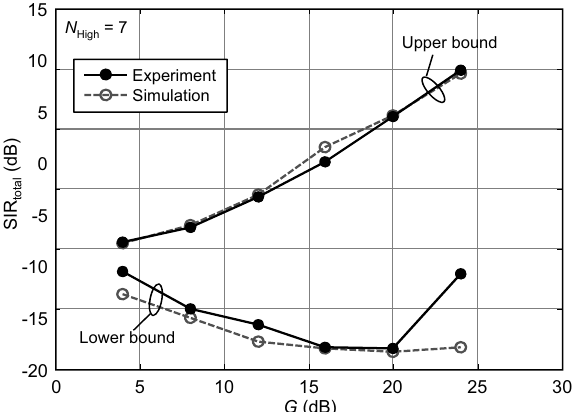
Figure 9. Operational SIR total range of the secondary system by subcarrier power ratio G ( N High = 7).